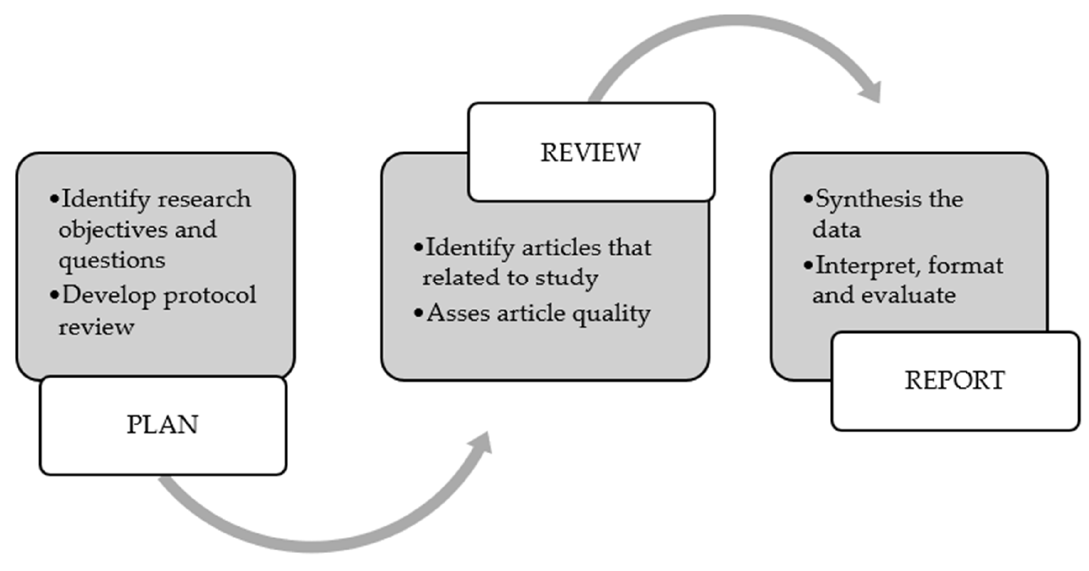
Figure 2. Systematic literature review approach [32].